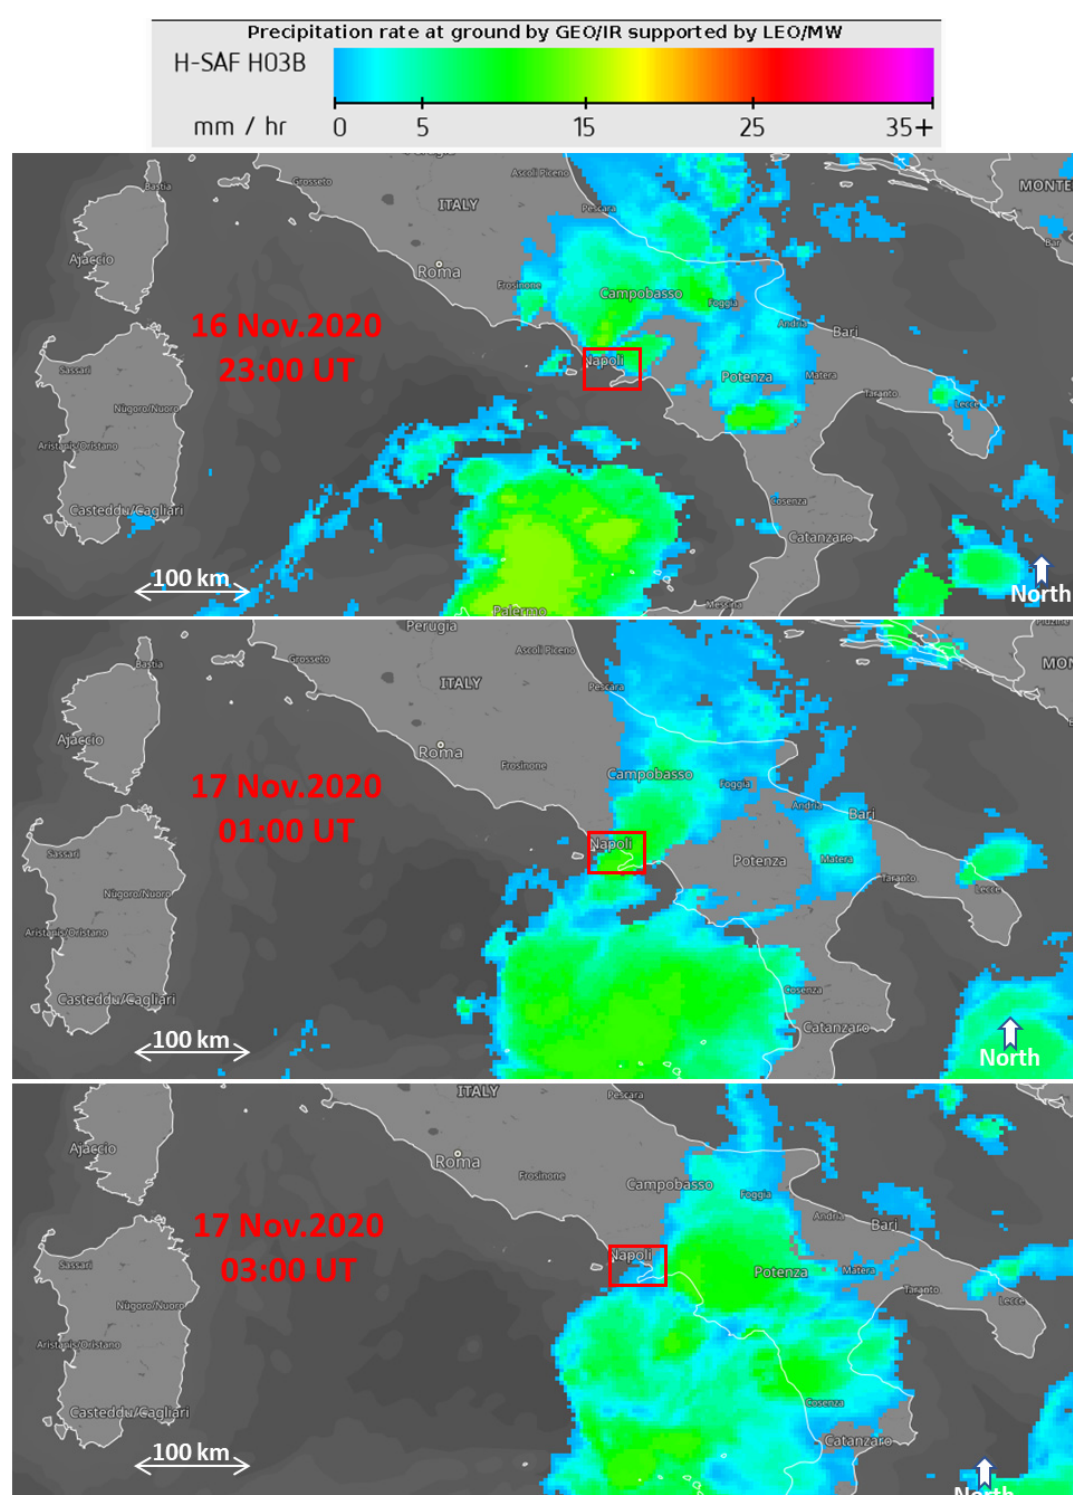
Figure 7. IR images from the SEVIRI instrument on-board Meteosat Second Generation (MSG) satellites “calibrated” by precipitation measurements from PMW satellite sensors in sun-synchronous orbits (EUMETSAT Data Service, 2021) [51]); the red box marks the target area (same as in Figure 1).